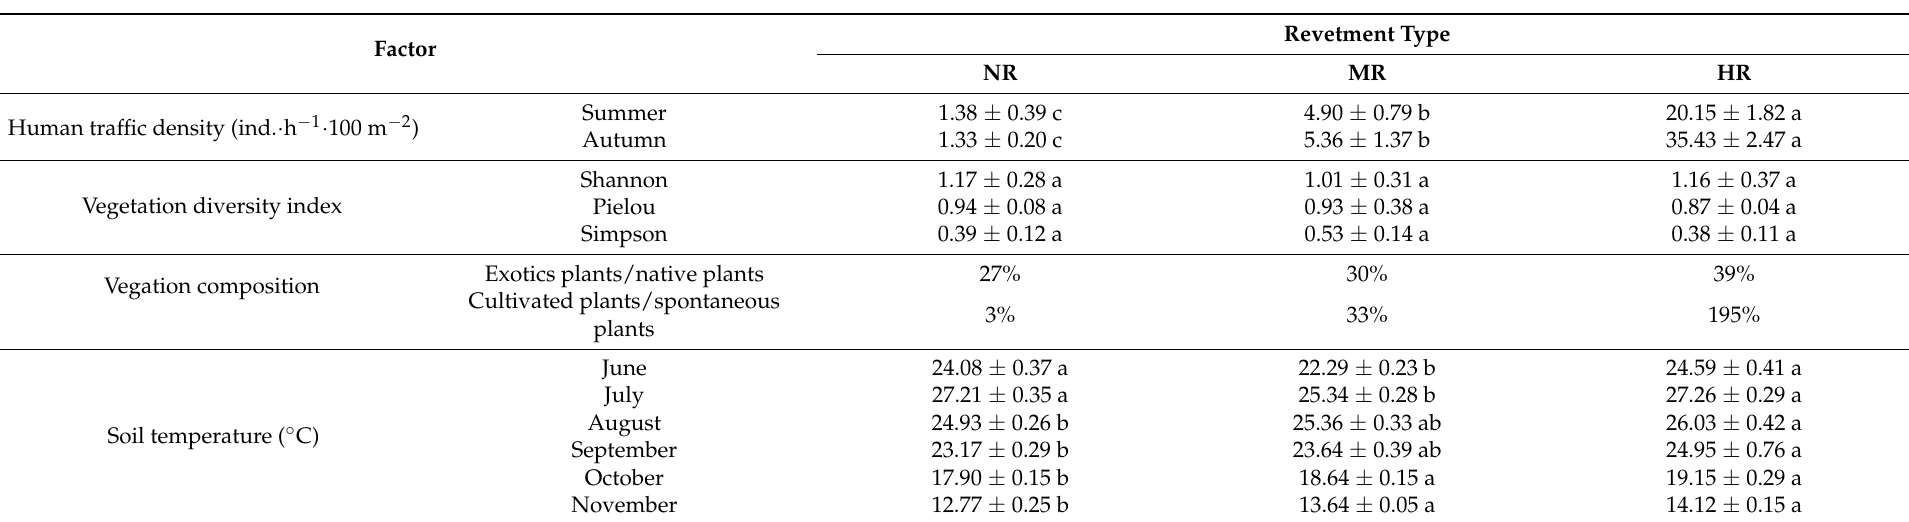
Table A2. Information on vegetation, human traffic, and soil temperature of different revetment sampling